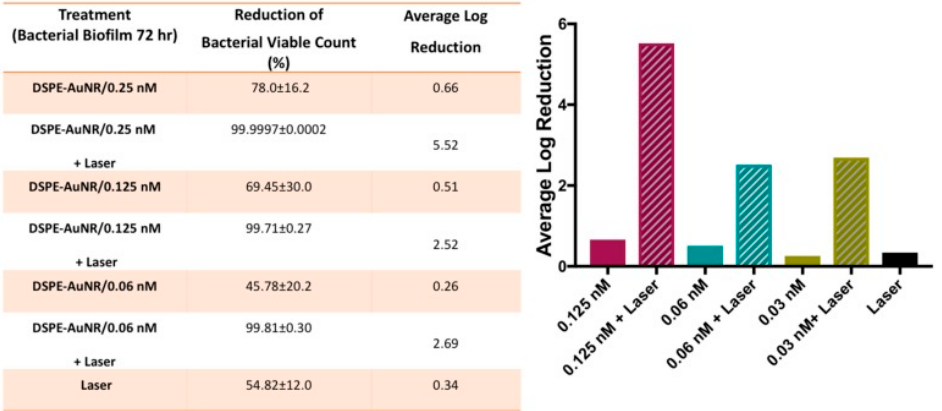
Figure 14. Antibacterial activity under NIR laser light by a phospholipid-conjugated gold nanorods (DSPE-AuNR) suspension loaded into a poloxamer 407 hydrogel against P. aeruginosa biofilm (72 h) using a continuous wave (CW) or pulsed laser at 3 and 1 W / cm 2 . (Left) Calculation of the percentage reductions in viable bacteria counts with AuNR / hydrogel after NIR laser excitation (CW vs. pulsed) and in dark conditions. (Right) Calculation of the average log reductions of viable bacterial counts after treatment with AuNR / hydrogel and NIR laser excitation (CW vs. pulsed) and under dark conditions. Reproduced from [116], with permission from MDPI, 2019.